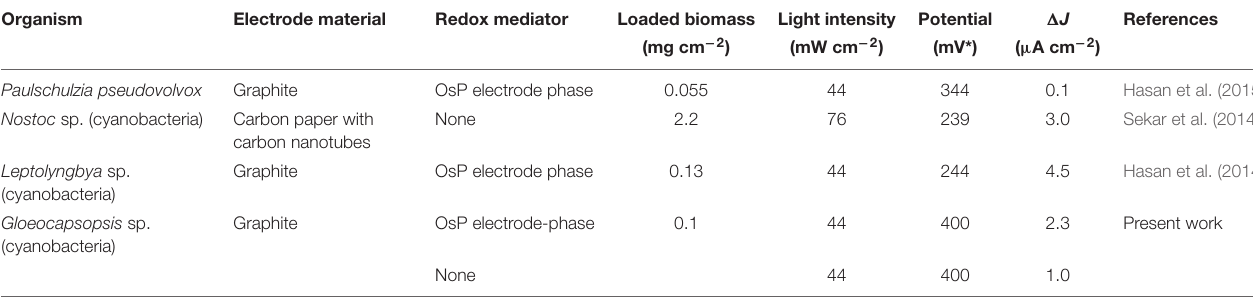
TABLE 3 | Comparison of photocurrent density output for various reports using whole living cells.